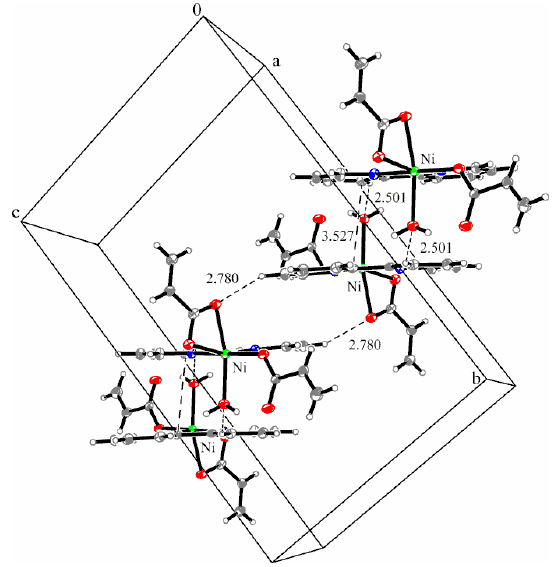
Figure 4. Packing diagram presenting the C–H … O hydrogen bonds and π … π interactions along the a - axis in complex ( 2 ). a -axis in complex ( 2